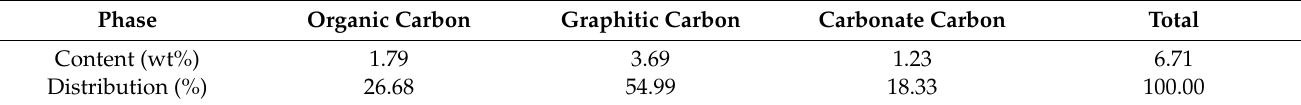
Table 2. Gold chemical-phase analysis results of the raw ore. Table 3. Carbon chemical phase analysis results of the raw